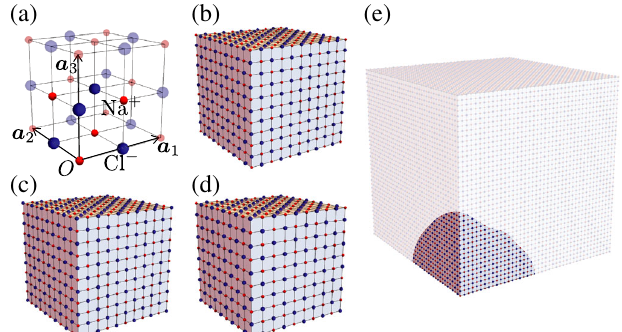
FIG. 1. (a) The conventional unit cell of NaCl. Na þ ions and Cl − ions are, respectively, located at Wyckoff position a and b of ¯3 m the space group Fm . Dimmed ions belong to neighboring cells. (b),(c) An O -symmetric cubic sample of NaCl with the side length L ¼ 5 a . All corners are occupied by a Na þ ion in (b), and by a Cl þ ion in (c). The total electric charge in the system is Q ¼ þ e in (b) and − e in (c). (d) An O -breaking, charge-neutral sample of NaCl with the side length L ¼ 4 . 5 a . Corners are occupied by Na þ ions and Cl þ ions alternatively. (e) Illustration of the irrelevance of the entire shape for a charge localized to a